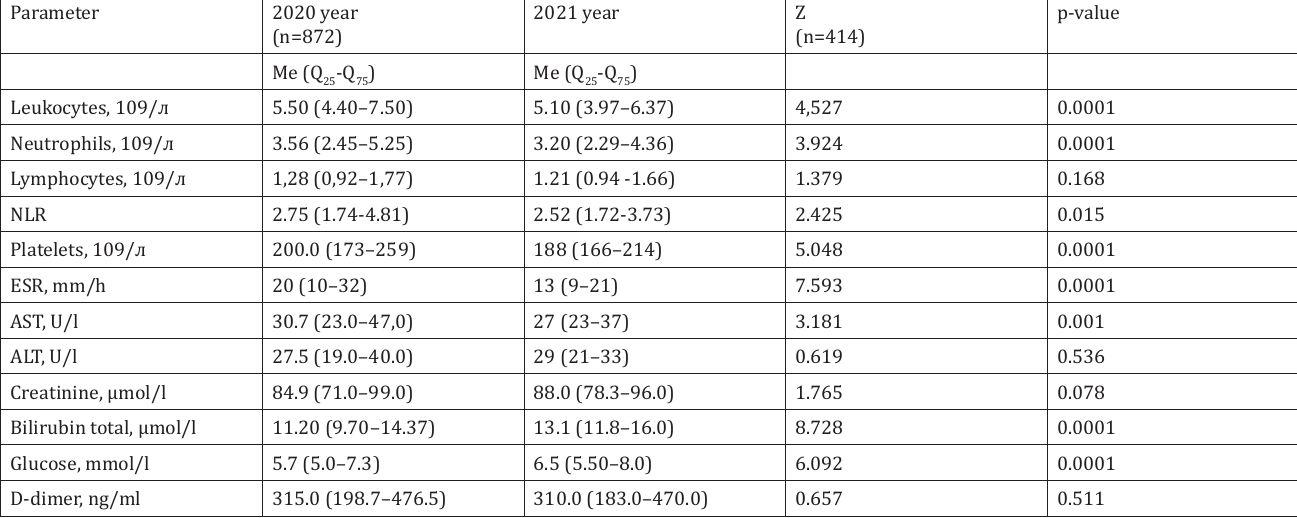
Laboratory parameters in patients hospitalized with COVID-19 in 2020 and 2021